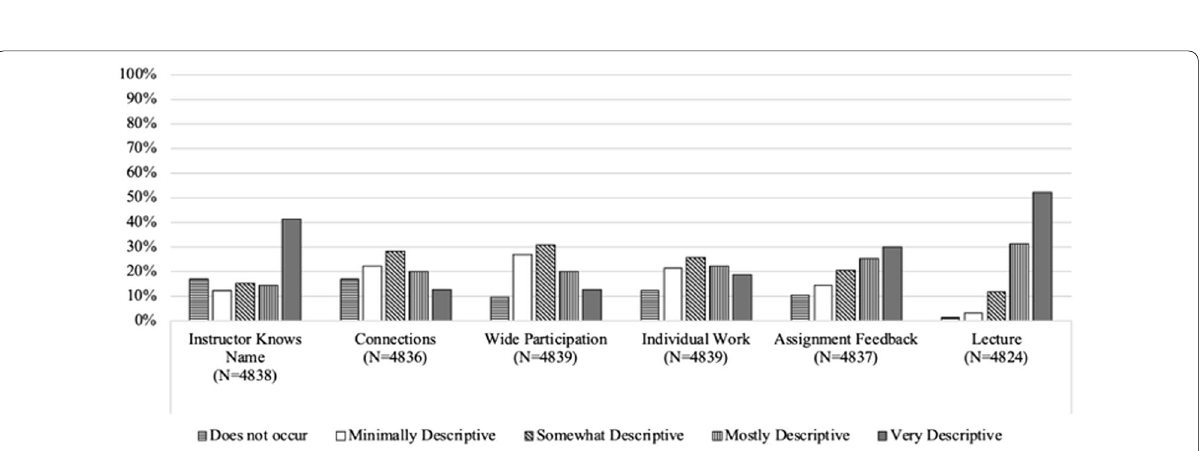
Fig. 2 Summary of descriptiveness of Other Classroom